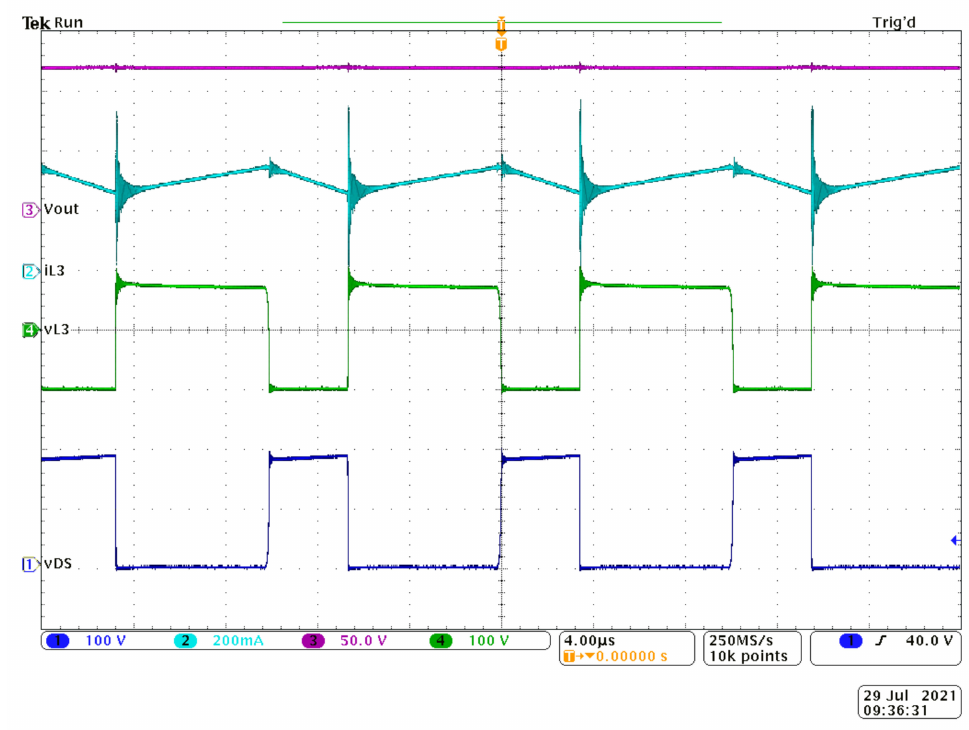
Figure 22. Oscilloscope waveforms: drain-to source-voltage (dark blue— v DS ); voltage across L 3 (green— v L 3 ); current through L 3 (cyan— i L 2 ) and output voltage (purple- V out